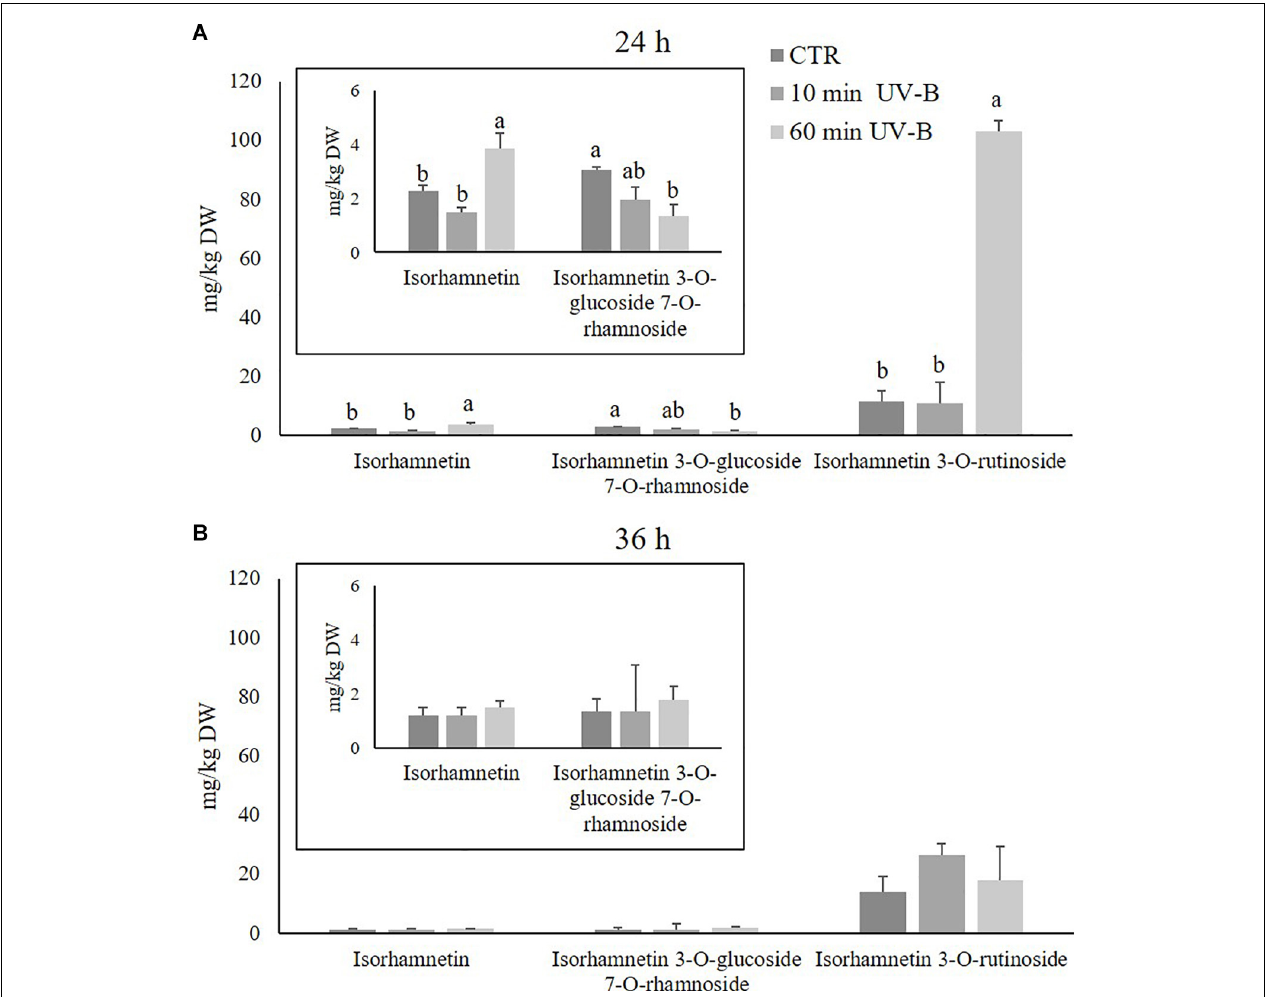
FIGURE 5 | Concentration (mg/kg DW) of different isorhamnetins in the pulp of peaches exposed to UV-B radiation for either 10 or 60 min and sampled after 24 h (A) and 36 h (B) from the exposure. (A) Isorhamnetin and isorhamnetin 3- O -glucoside 7- O -rhamnoside were reported also in a different, framed histogram with a lower y-axis scale (0–6 mg/kg DW) for a better visualization. Data are mean ± SE of five biological replicates. Different letters correspond to statistically significant differences according to one-way ANOVA followed by Tukey–Kramer post hoc test ( P ≤ 0.05).